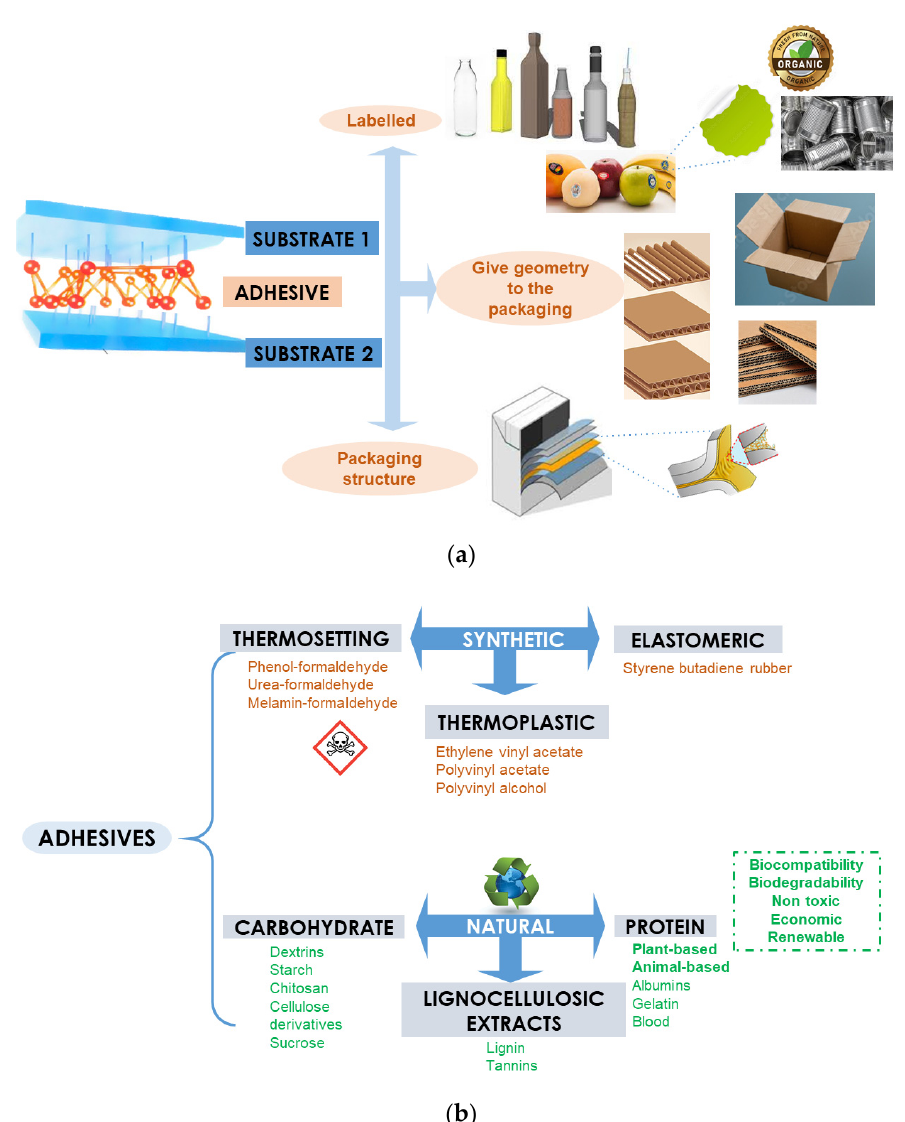
Figure 4. ( a ) Schematic representation of the function of adhesives in food packaging on different substrates; ( b ) Classification of adhesives according to the source of the polymers. substrates; ( b ) Classification of adhesives according to the source of the